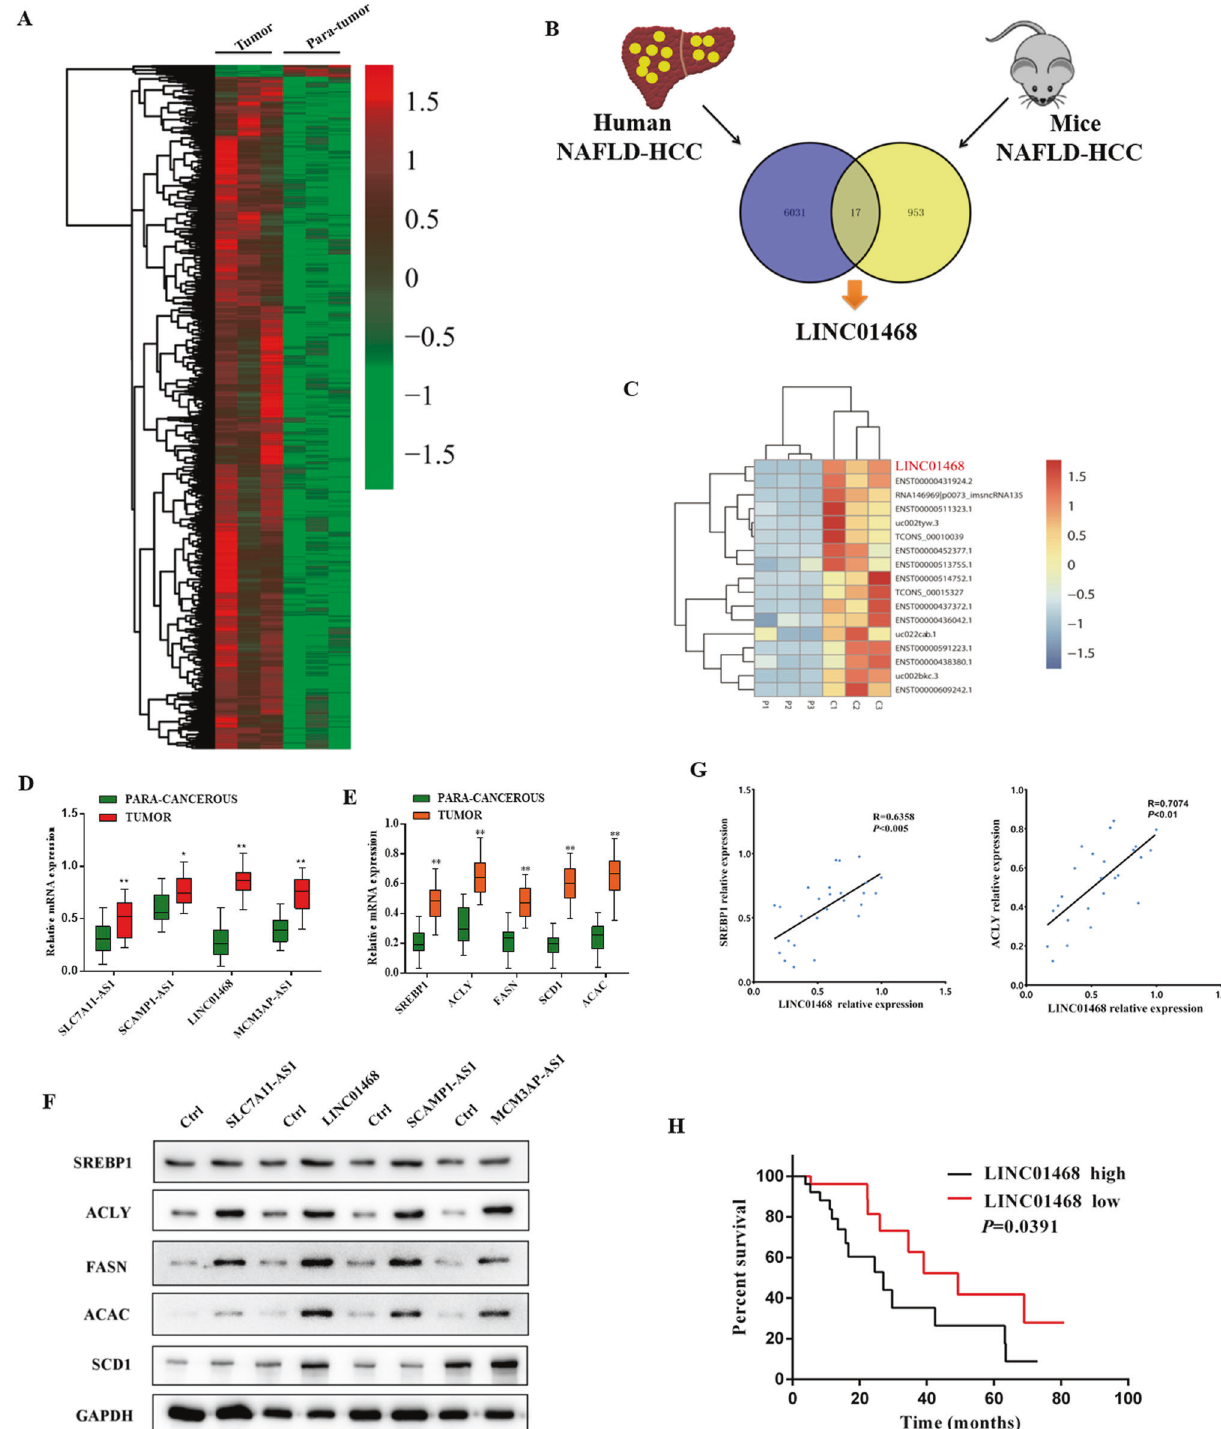
Fig. 1 LINC01468 is especially upregulated in liver tissues during NAFLD-HCC. A Heatmap summarizing RNA-Seq data for human HCC with or without NAFLD with 5944 upregulated genes (pink) and 104 downregulated genes (green). B Overlapping of the 17 genes signi fi cantly altered in both human ( n = 3) and mice ( n = 3) NAFLD-HCC ( P < 1.78 × 10 − 9 ). C Part of the genes described in B . D qRT-PCR was used to assess the relative expression levels of four lncRNAs in 26 paired peritumoral tissues and HCC tissues (** P < 0.01) . E qRT-PCR was used to determine the levels of lipogenic enzymes and prolipogenic transcription factor in 26 paired HCC tissues and peritumoral tissues. F Representative immunoblotting results for the major lipogenesis protein with or without the indicated LncRNA overexpression in Huh7 cell line. G Scatter- plot analysis of the correlation between the mRNA levels of LINC01468 and SREBP1 or ACLY in 26 HCC tissues. H Kaplan – Meier analysis of the correlation of LINC01468 expression with overall survival.